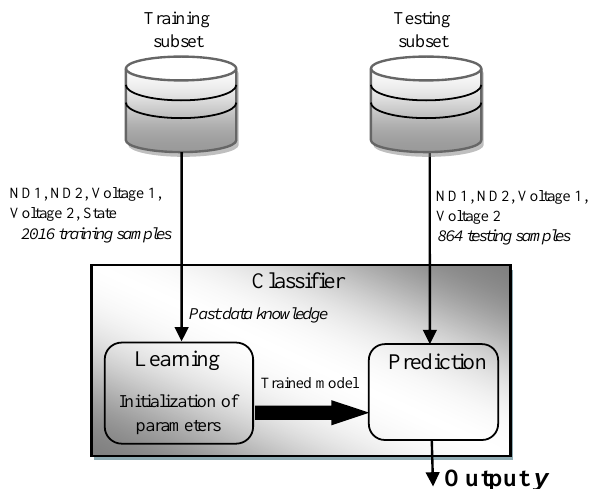
Figure 10. Flowchart of the classification process: from the model training to the prediction.